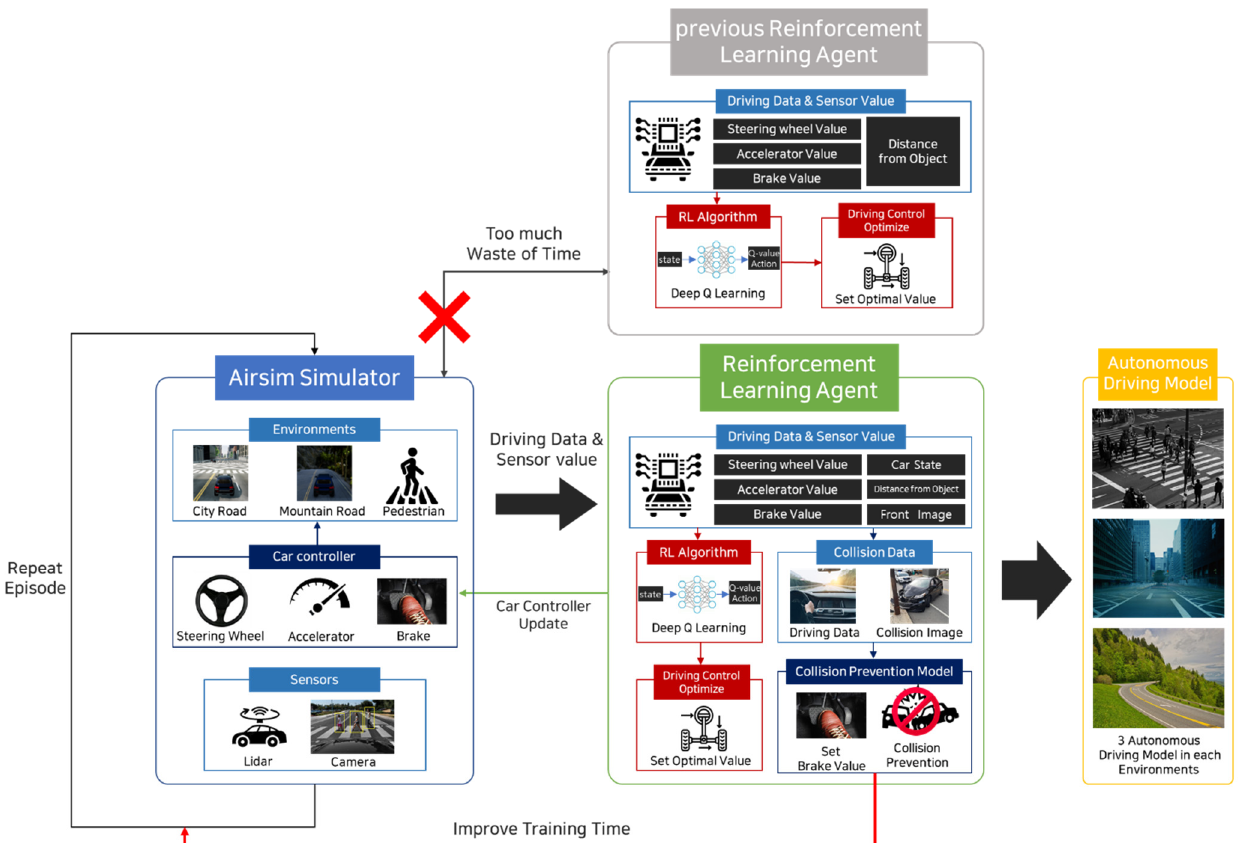
Figure 2. Overall flow chart of the proposed simulation.